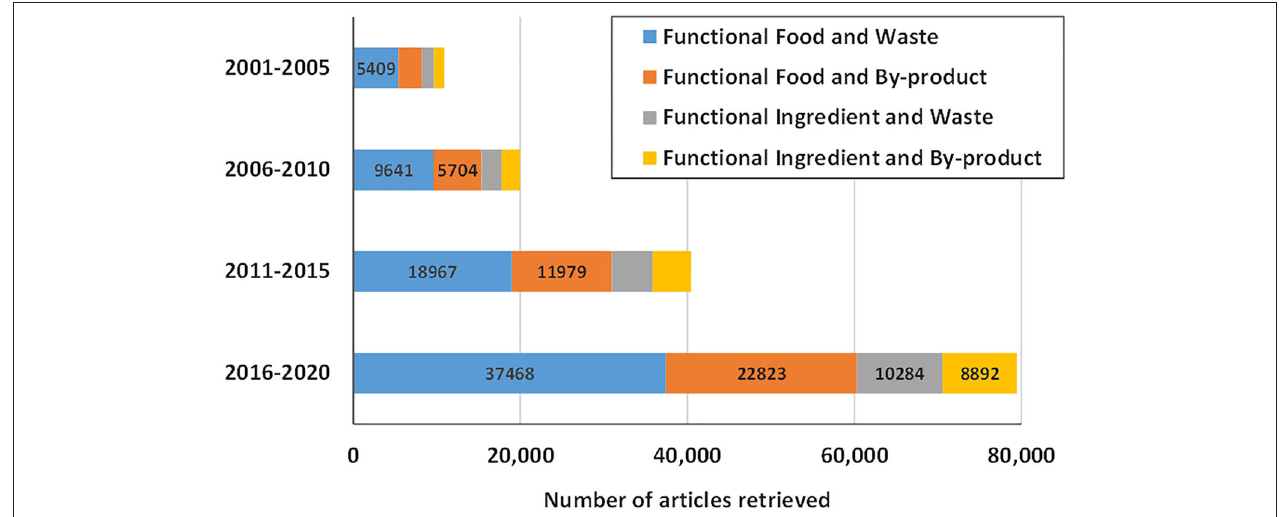
FIGURE 1 | Evolution in the number of published articles (retrieved from Science Direct) using the combination of keywords “Functional Food” and “Waste,” “Functional Food” and “By-Product,” “Functional Ingredients ” and “Waste,” “Functional Ingredient” and